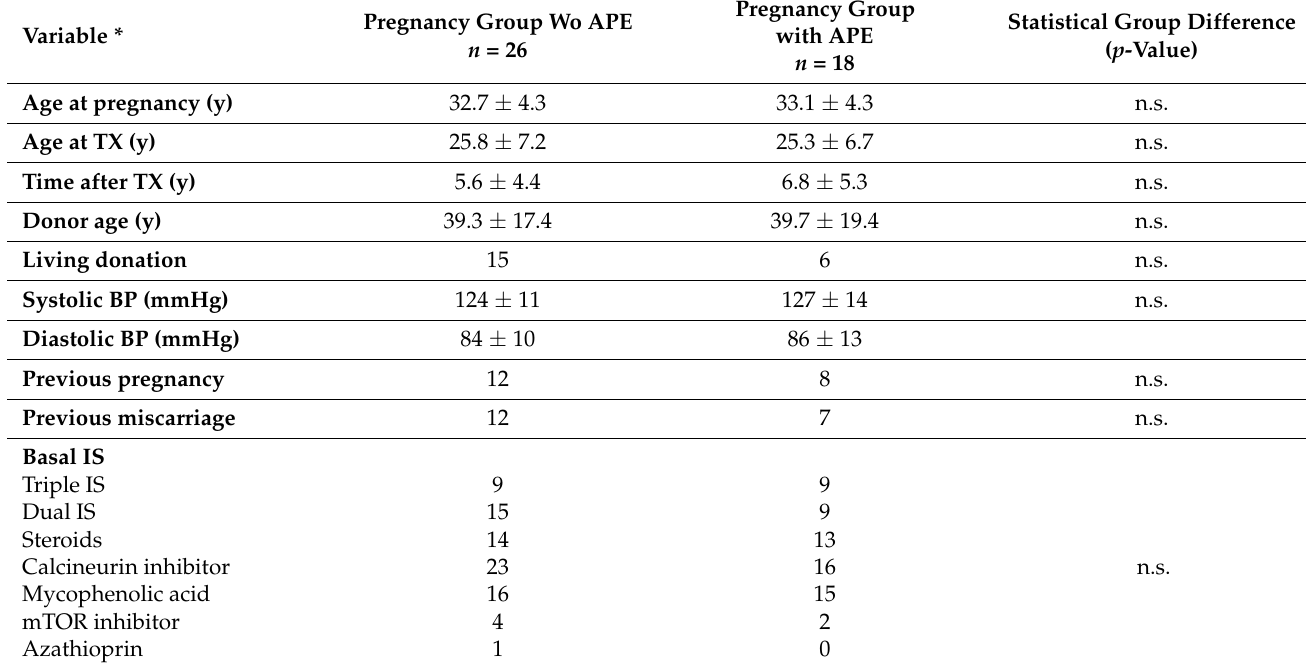
Table 3. Characteristics stratified by status for adverse pregnancy